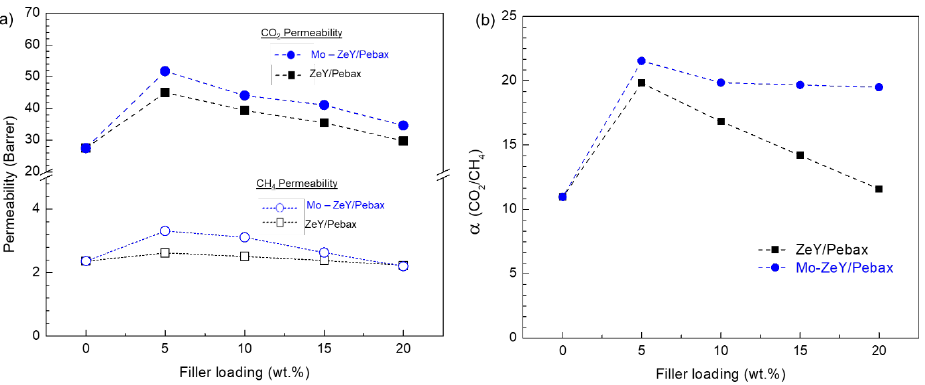
Figure 8. ( a ) Gas permeability and ( b ) CO 2 /CH 4 separation factor of MMMs with ZeY or Mo-ZeY at Figure 8. (a) Gas permeability and (b) CO 2 /CH 4 separation factor of MMMs with ZeY or Mo-ZeY at various filler loading. various filler loadings. The membranes were tested at 1 bar of transmembrane pressure and 30 ◦ C. The membranes were tested at 1 bar of transmembrane pressure and 30 °C. The gas permeability and separation factor of MMMs from both ZeY and